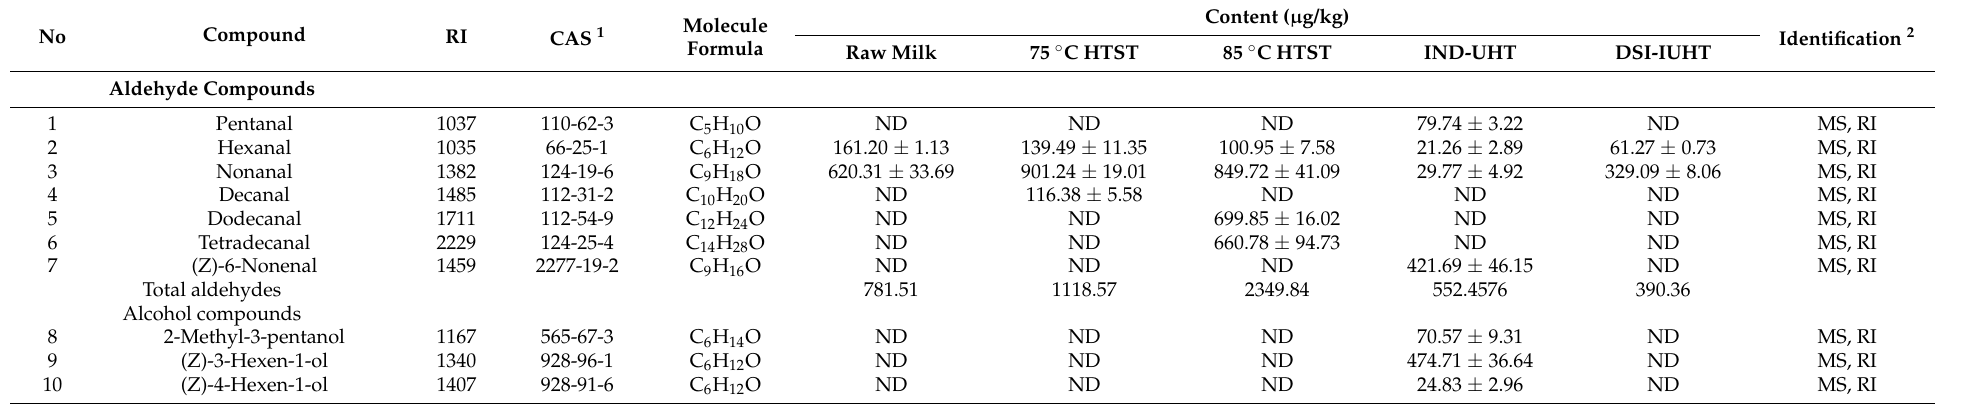
Table 3. Solvent-assisted flavor evaporation (SAFE) analysis of the VC contents in the different milk